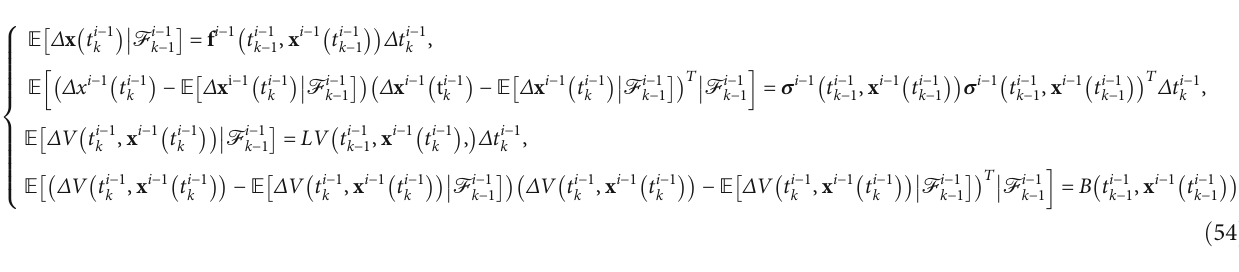
. With regard to the continuous time dynamic t i − 1 k − 1